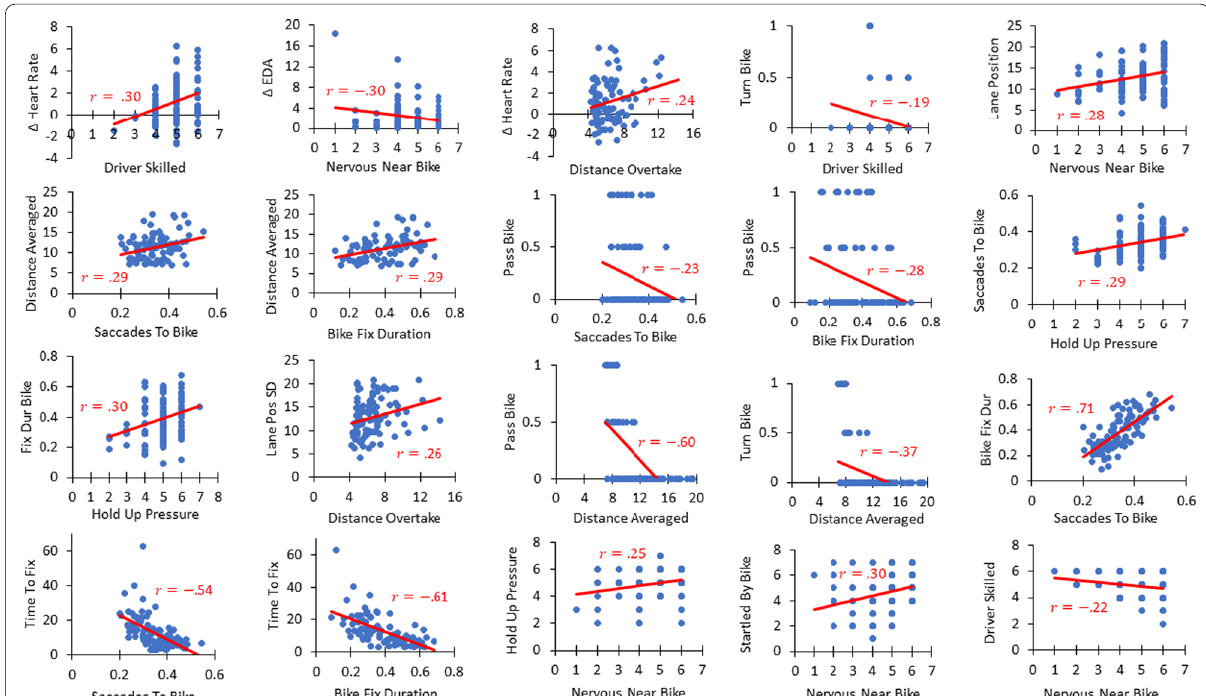
Fig. 4 Significant relationships (uncorrected for multiple comparisons) between physiological, eye-tracking, driving, and self-report